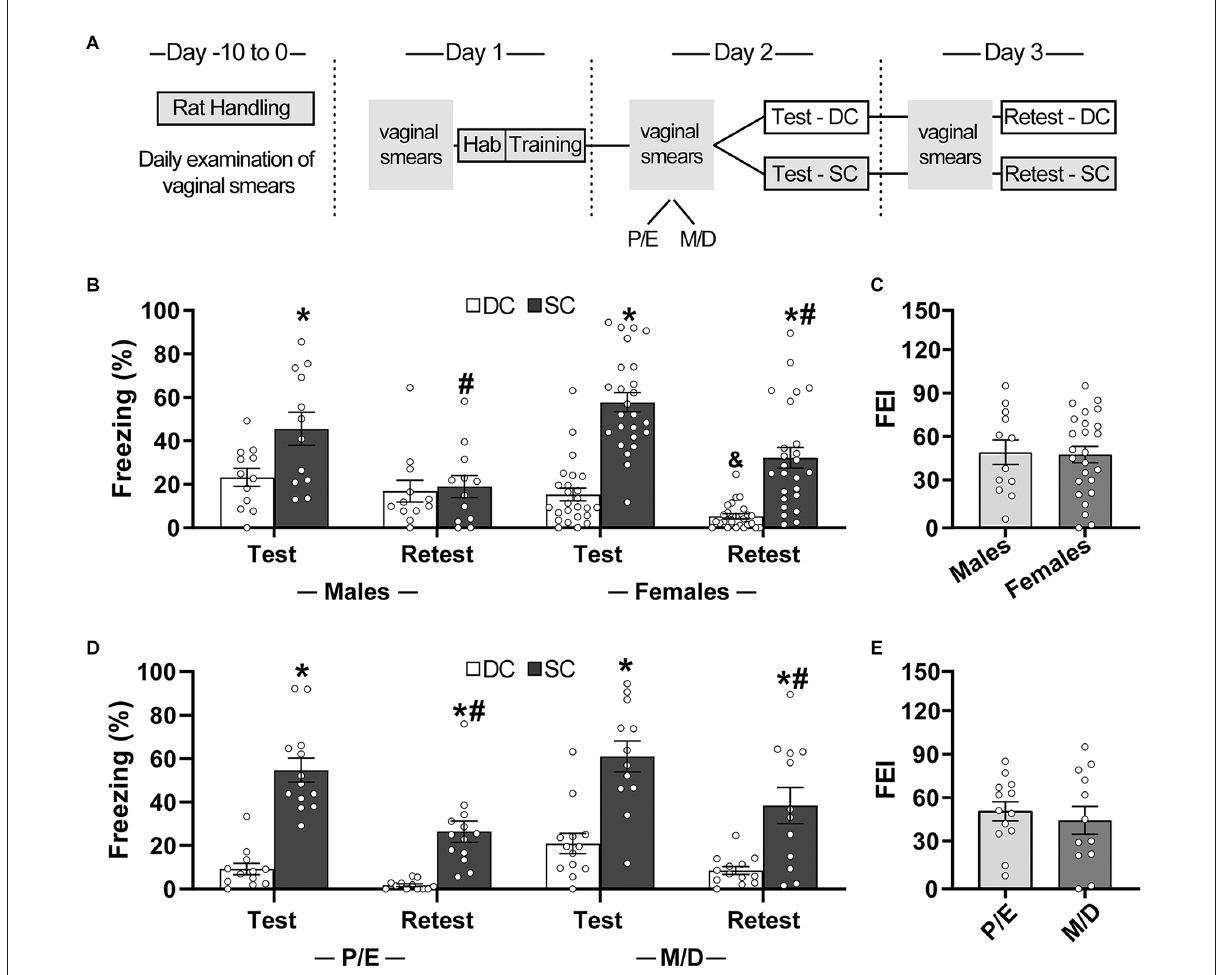
FIGURE1 Expression (test) and extinction (retest) of contextual conditioned fear did not differ between male and female rats. (A) Timeline of the experimental procedure. (B,D) Mean percentage of freezing during test and retest sessions (time spent freezing during session/session duration *100) for different-context (DC) and same-context (SC) groups. (C,E) Fear extinction index (FEI; % freezing exhibited during the final block of the training session − % freezing exhibited during retest session). * p < 0.05: different from the DC group in the same session; # p < 0.05: different from the same group during the test session; & p < 0.05: different from the male DC group at retest. Males: n = 12 for DC and SC; Females proestrus/estrus (P/E): n = 12 for DC and 13 for SC; Females metestrus/diestrus (M/D): n = 13 for DC and 12 for SC.